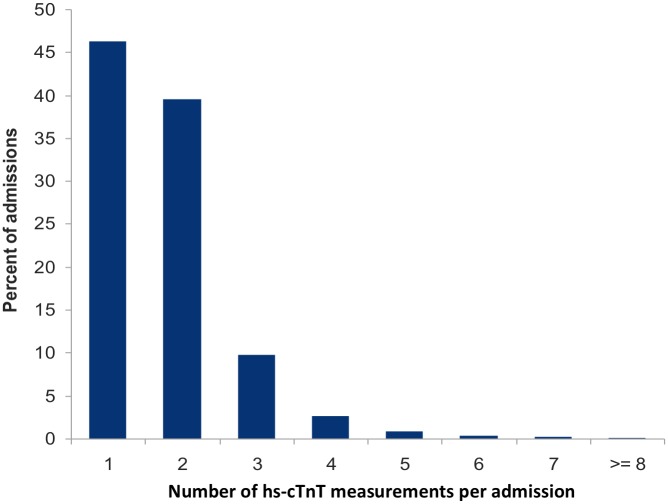
Distribution of high sensitivity troponin measurements per admission.Two or more hs-cTnT measurements were obtained in a little more than half of the hospital admissions in which Hs-cTnT measurements were observed.